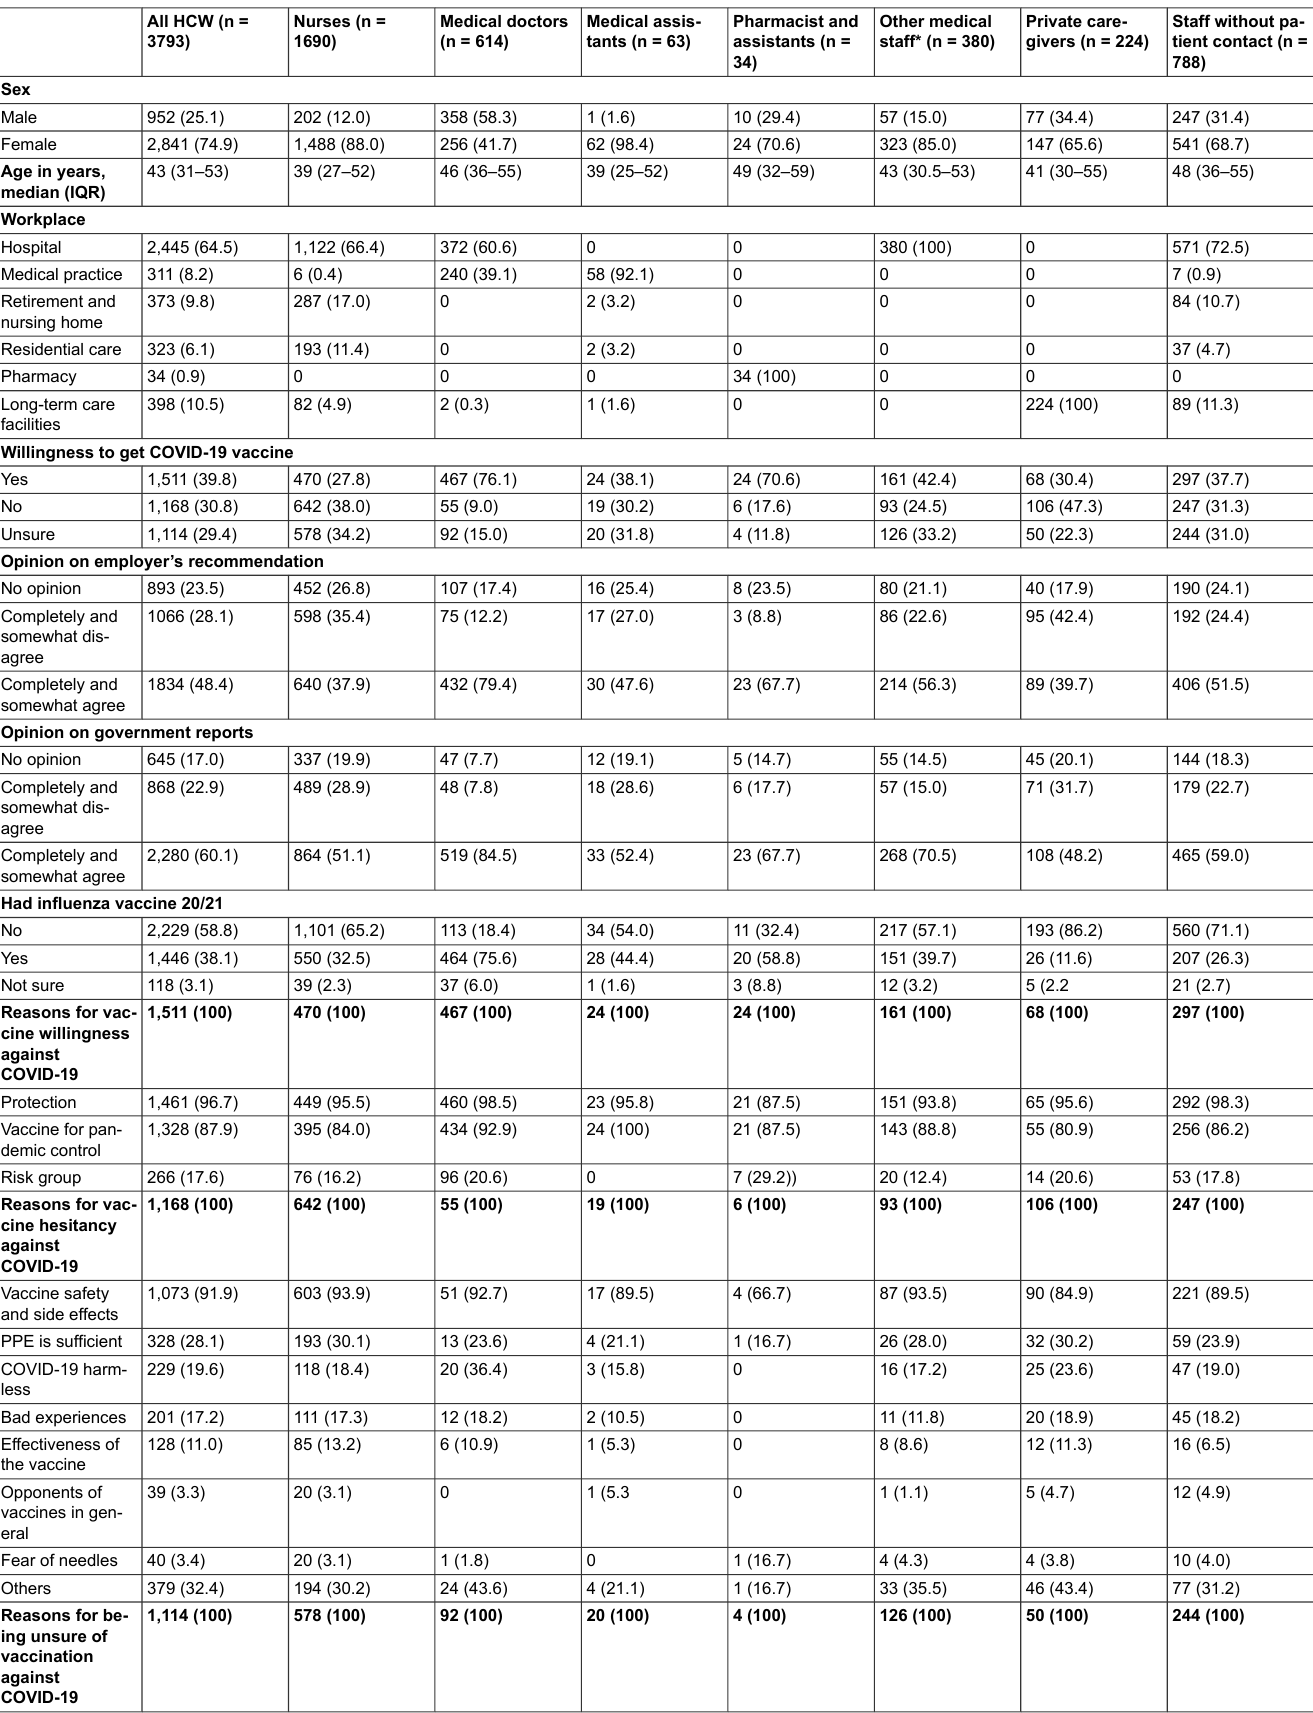
Table 1: Characteristics of healthcare workers participating in the survey, overall and by profession. All HCW (n = Nurses (n = 3793)